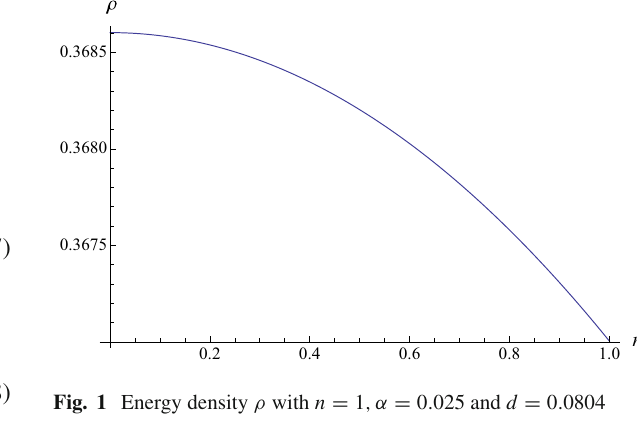
Fig. 1 Energy density ρ with n = 1 ,α = 0 . 025 and d = 0 . 0804